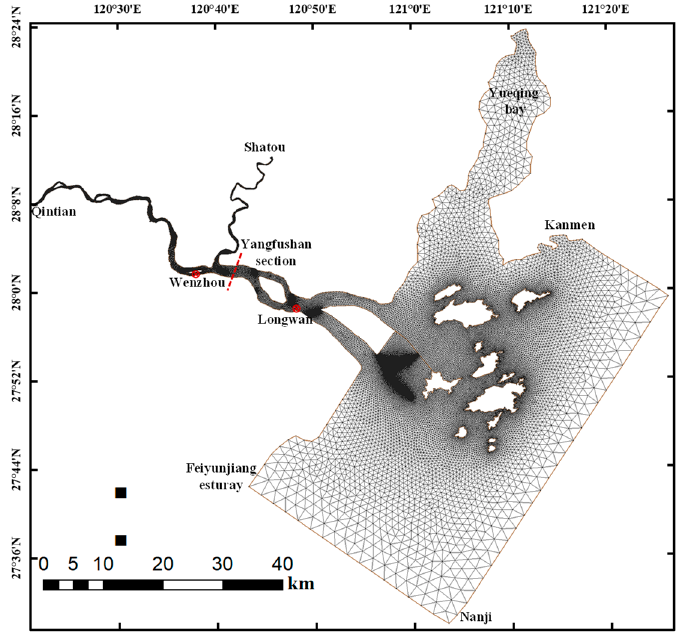
Figure 2. Numerical simulation calculation range and grid